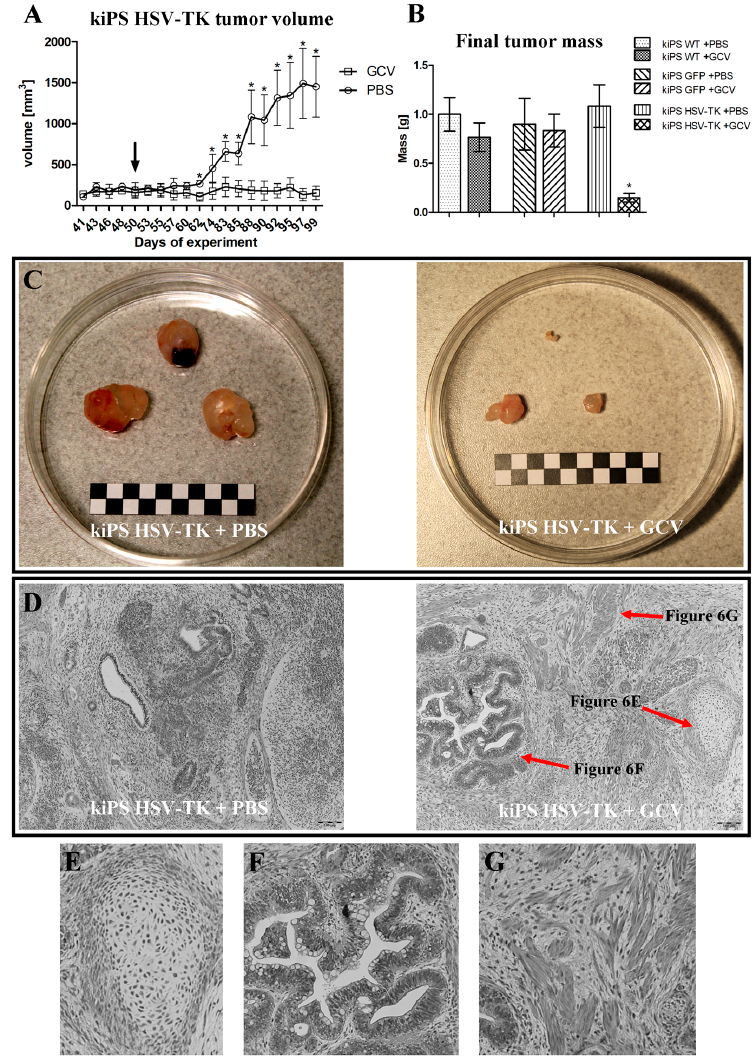
Figure 6. Ganciclovir efficiently eliminates tumors formed by HSV-TK expressing kiPS cells. After formation of tumors mice were daily injected with saline (PBS) or 50 mg/kg ganciclovir (GCV) intraperitoneally for 42 days. Growth of kiPS HSV-TK teratomas was abrogated after administration of ganciclovir (start of treatment is pointed by black arrow). ( A ) kiPS HSV-TK tumor volume during experiment; ( B ) final tumor mass; ( C ) dissected tumors; and ( D ) histopathologic images of kiPS HSV-TK-formed teratomas containing three germ layer derivatives: ( E ) cartilage; ( F ) secreting epithelium; and ( G ) muscle. Data in ( A , B ) are presented as mean ± standard error. * indicate statistically significant difference ( p < 0.05) vs. appropriate control tested by Mann–Whitney U -test. Representative data for one of two replicates, in each n = 3. White and black squares in ( C ) represent 5 mm; and ( D – G ) magnification 100×, bars represent 100 µm.